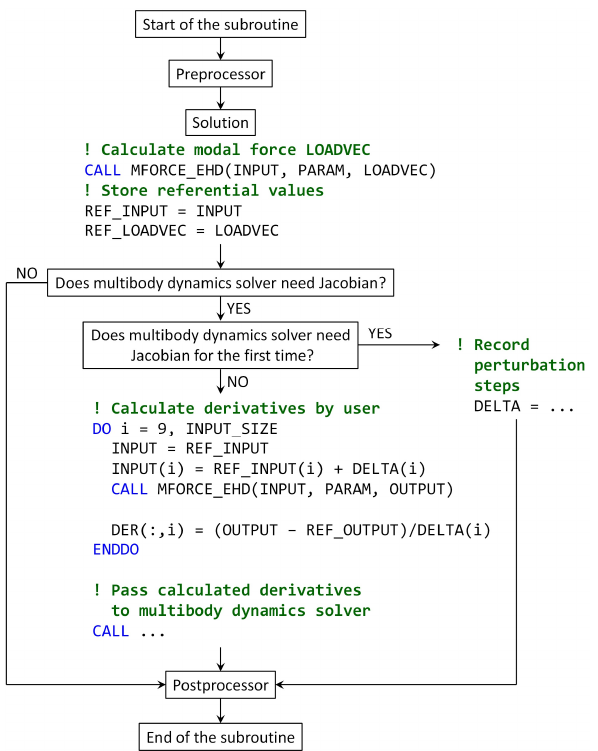
Figure 5. Scheme of sensitivity analysis of the subroutine using the User finite forward difference method for deformation-related measurements in Fortran. The modal force LOADVEC is calculated using function MFORCE_EHD based on measurements INPUT and parameters PARAM. If the multibody dynamics solver is calculating the Jacobian for the first time, the subroutine records the perturbation steps DELTA. Otherwise, the subroutine calculates the partial derivatives of Equation (29), stores them in DER, and passes them to the multibody dynamics solver.